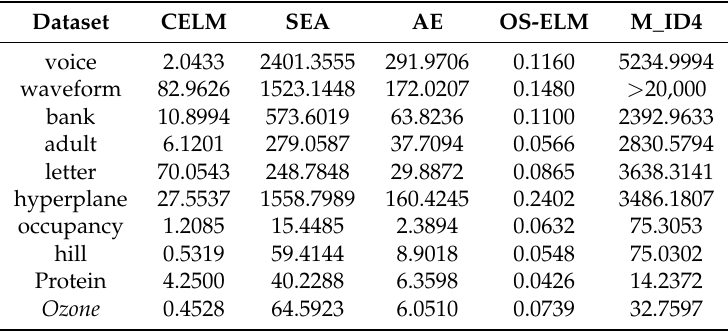
Table 3. The time consumption of the algorithms on the experimental